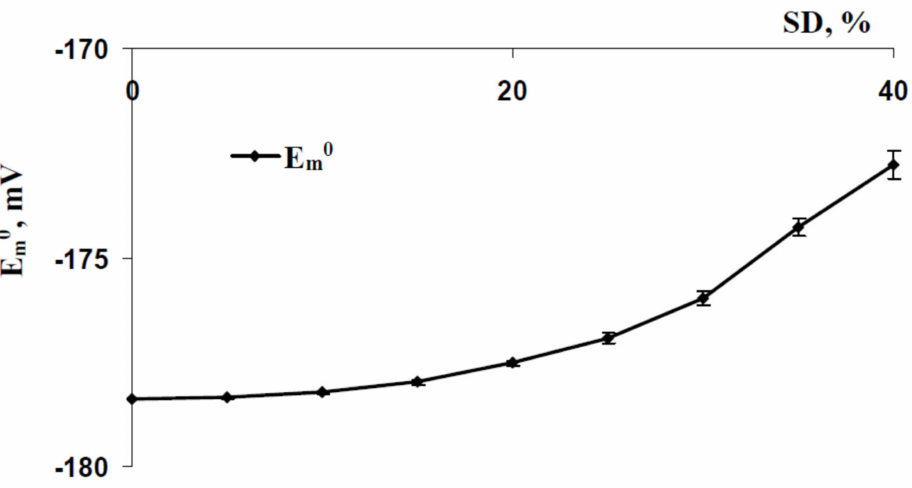
Figure 5. Dependence of the averaged simulated membrane potential at rest (E m0 ) on the standard deviation of initial H + -ATP-ase activity in cells (SD) ( n =